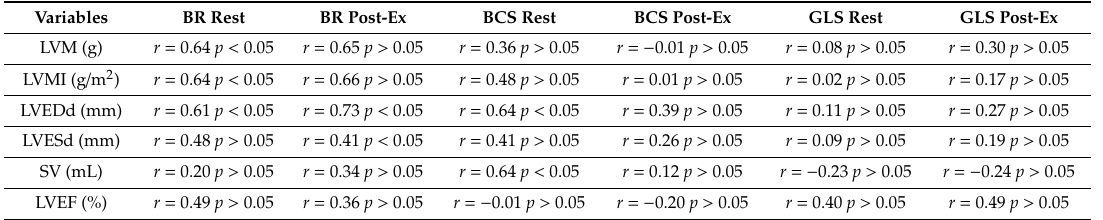
Table 4. Correlations between echocardiographic variables and speckle tracking echocardiography (STE) measures at